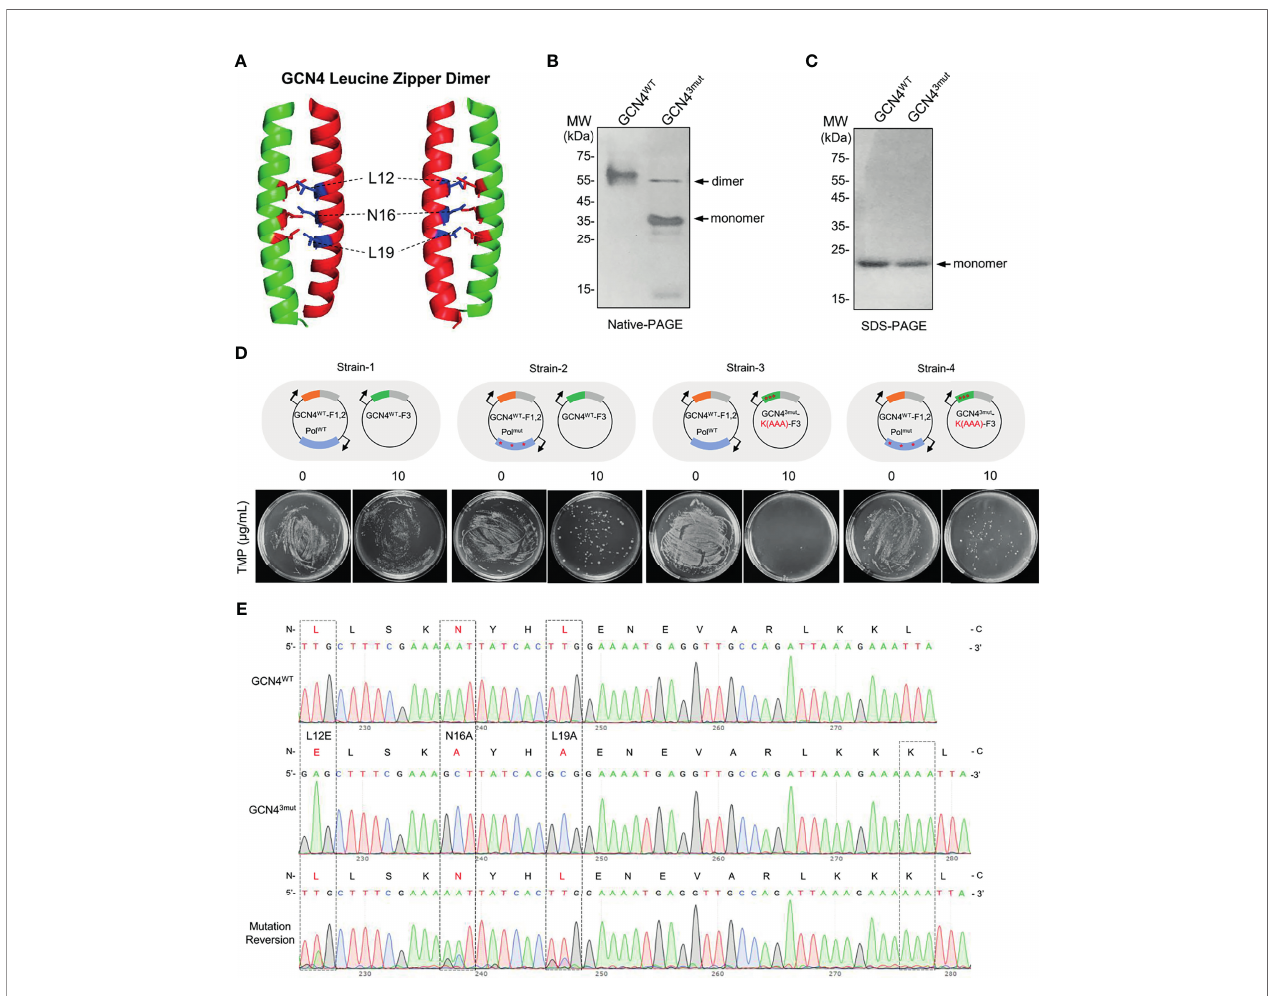
FIGURE 2 | Recovery of the homodimer formation activity in mutated GCN4 by EASINESS. (A) The structure of the GCN4 leucine zipper dimer (PDB: 1CE9). (B, C) Native and SDS-polyacrylamide gel electrophoresis (PAGE) analysis of the dimer formation of GCN4 WT and GCN4 3mut (L12E, L19A, and N16A). (D, E) Reversing the mutation of GCN4 3mut using EASINESS. Strain-4 carrying the mutation plasmid pEP (PolI 3mut ) was grown in the presence of 10 m g/ml TMP, and three mutation sites were reversed from GCN4 3mut to GCN4 WT according to Sanger sequencing. Strain-1: GCN4 WT -F1,2 and GCN4 WT -F3 with pWT (PolI WT ), Strain-2: GCN4 WT -F1,2 and GCN4 WT -F3 with pEP (PolI 3mut ), Strain-3: GCN4 WT -F1,2 and GCN4 3mut -F3 with pWT, Strain-4: GCN4 WT -F1,2 and GCN4 3mut -F3 with pEP. An additional mutation (AAA) at the end of GCN4 3mut was applied as a marker to differentiate the reversed mutant from wild-type